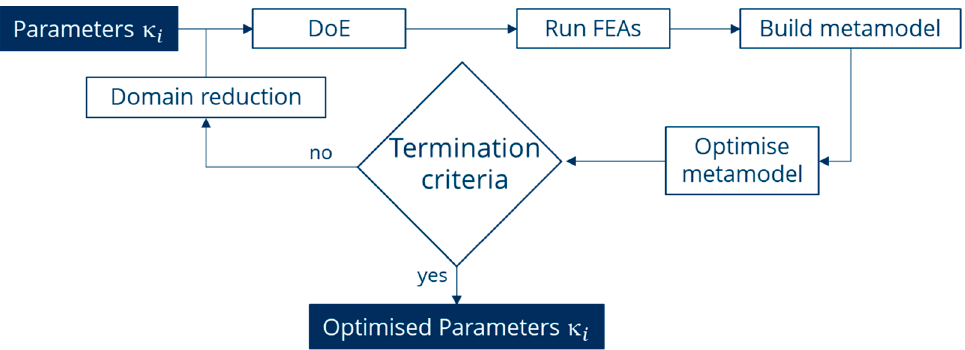
Figure 7. Framework of the applied metamodel-based optimisation.